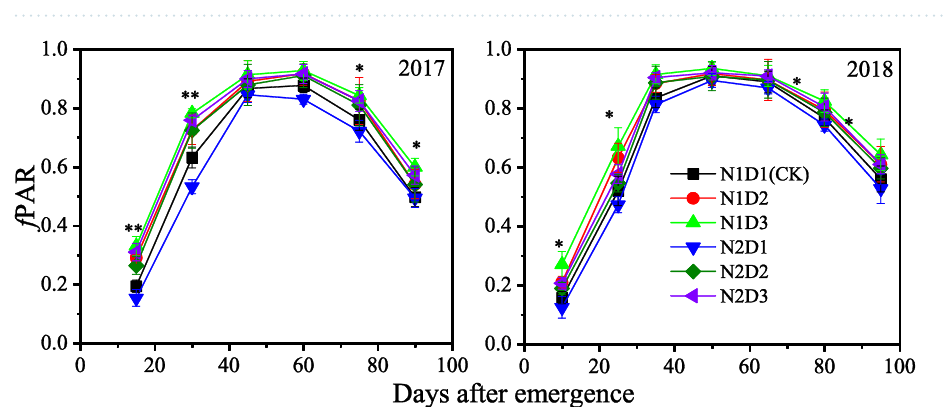
Figure 4. Changes in fraction of PAR intercepted ( f PAR) by maize affected by planting treatments during the growing season. Each data point is the mean ± S.E. of three replications with * and ** are significant at P < 0.05 and P < 0.01,